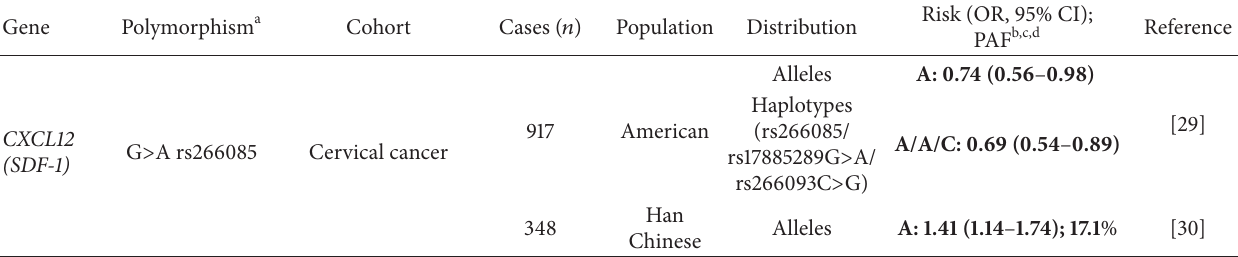
Table 3: Overview of polymorphisms in gene encoding chemokines and association with cervical neoplasia risk.